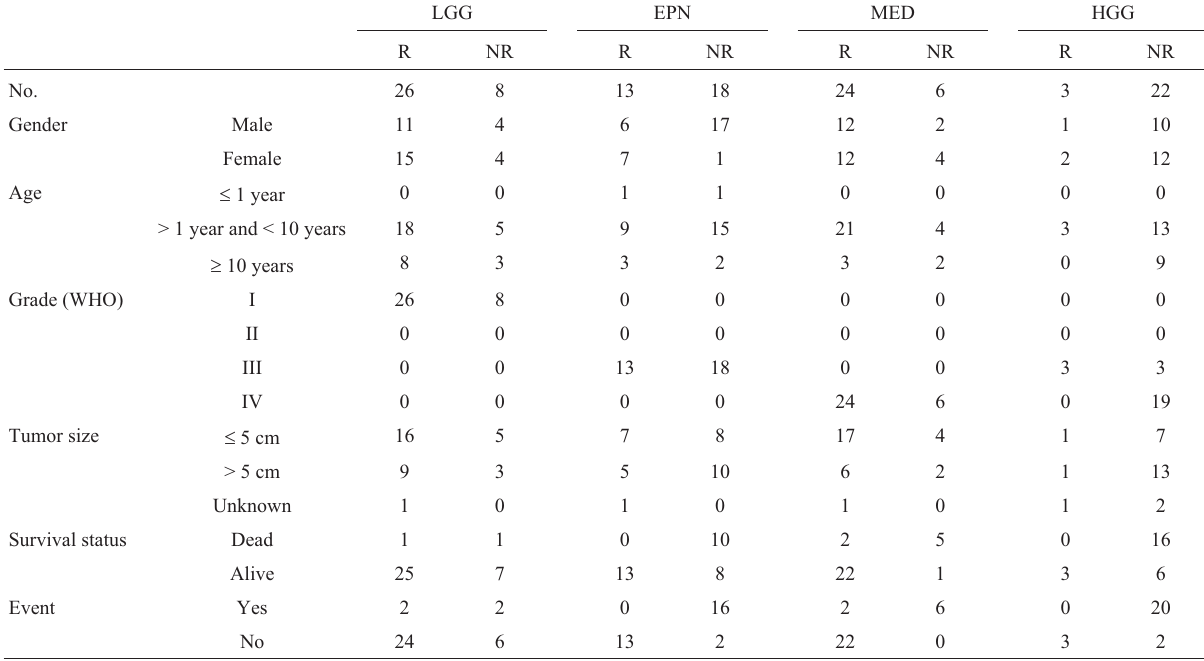
Table 2 - Clinicopathological features of pediatric brain tumor patients according to treatment